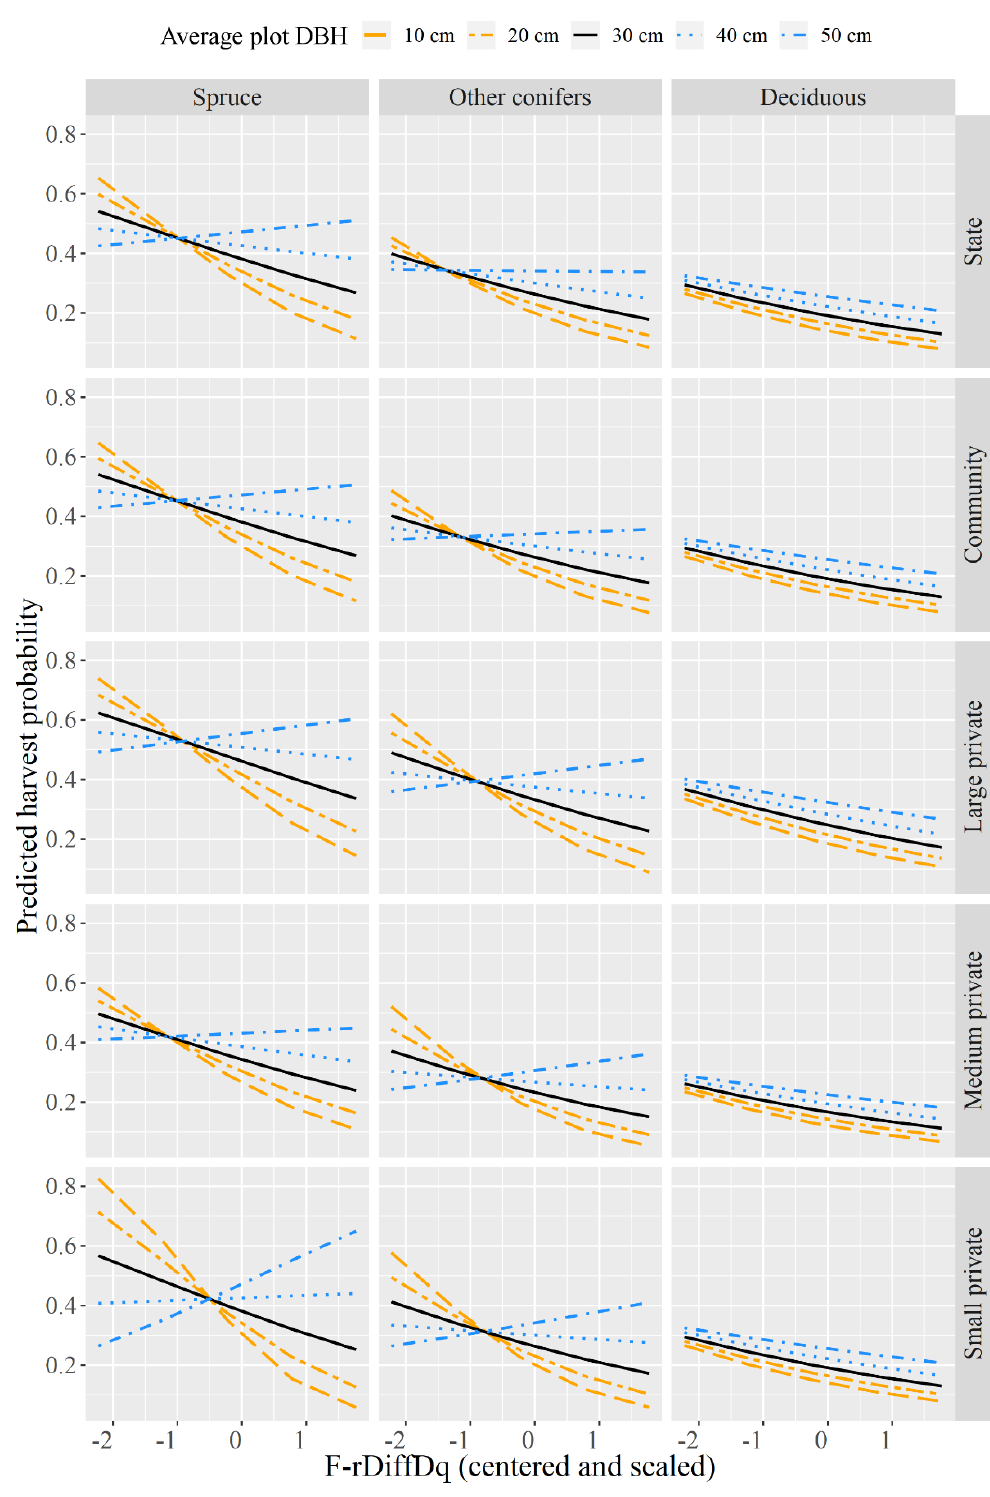
Figure A2. Effect of the interaction between F-rDiffDq, average diameter at breast height (DBH) of trees on the plot, (grouped) species, and ownership type on tree-level harvest probability predictions within the generalized linear mixed model (GLMM). For the visualization, values of all other variables were constant (unpruned; no damages; favorable harvest conditions; plot harvest stratum attribute group 3; training set mean values for numeric attributes). Spruce refers to Picea spp.